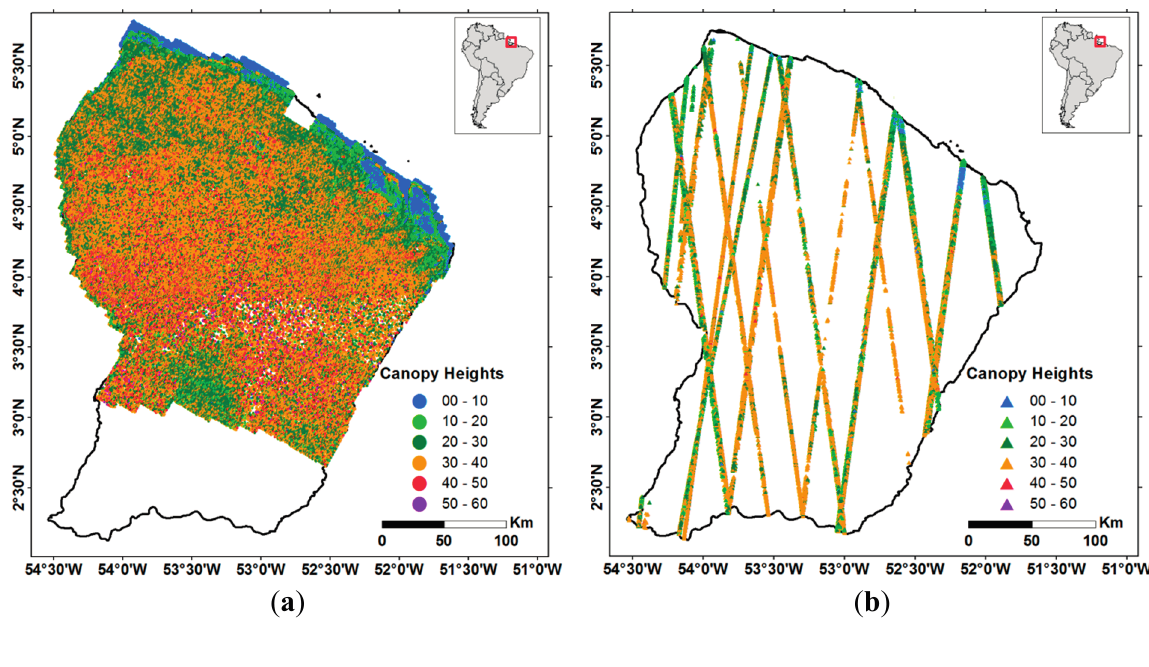
Figure 8. ( a ) Map of canopy heights estimated from the LD dataset; ( b ) Map of canopy heights estimated from the GLAS dataset using the PCA model; ( c ) Overlapping of the two maps over a small area of French